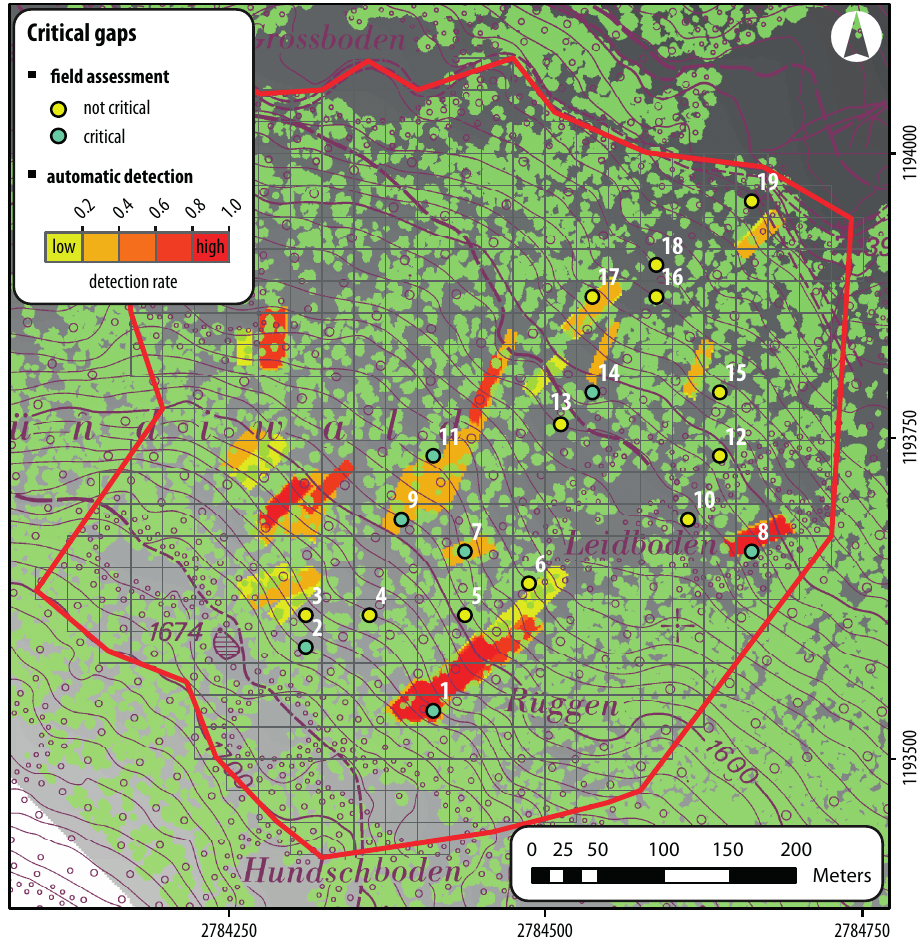
Figure 8. Results of the critical-gap classification based on the automatic detection and the results of the field assessment. Topographic map: Uebersichtsplan (UP), Canton of Grisons, 17 January